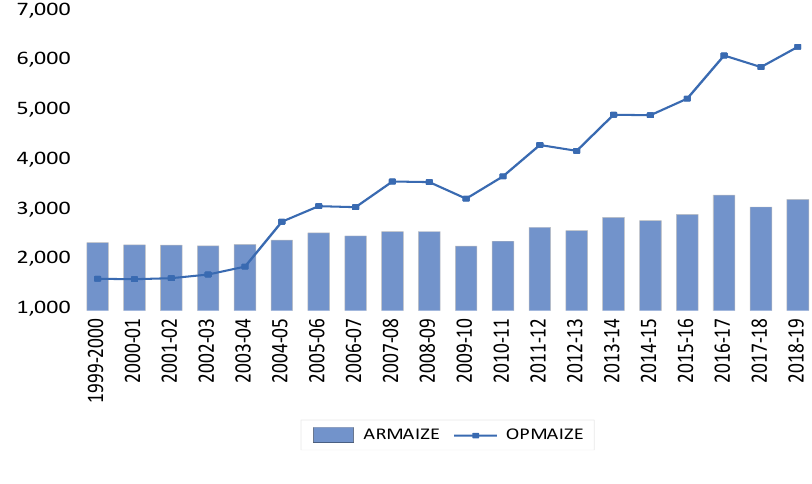
Figure 4: Area and Yield of Maize crops, 1999 –